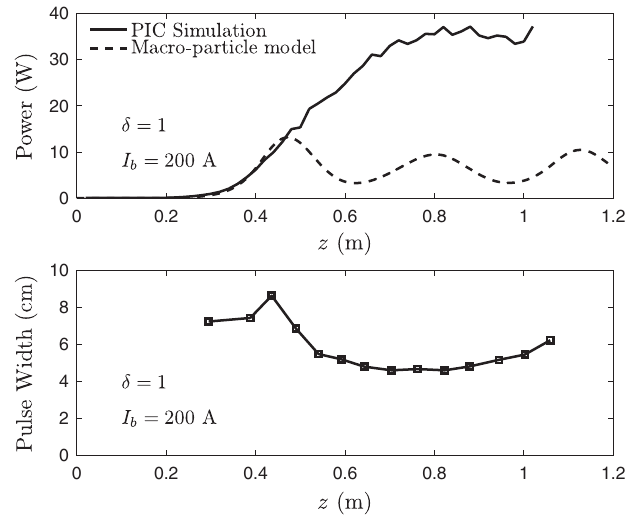
FIG. 25. Microwave power for superradiant pulse and the steady-state result for a 200 A beam with (cid:1) ¼ 1 . The pulse ultimately saturates as the pulse width approaches the coopera- tion length.